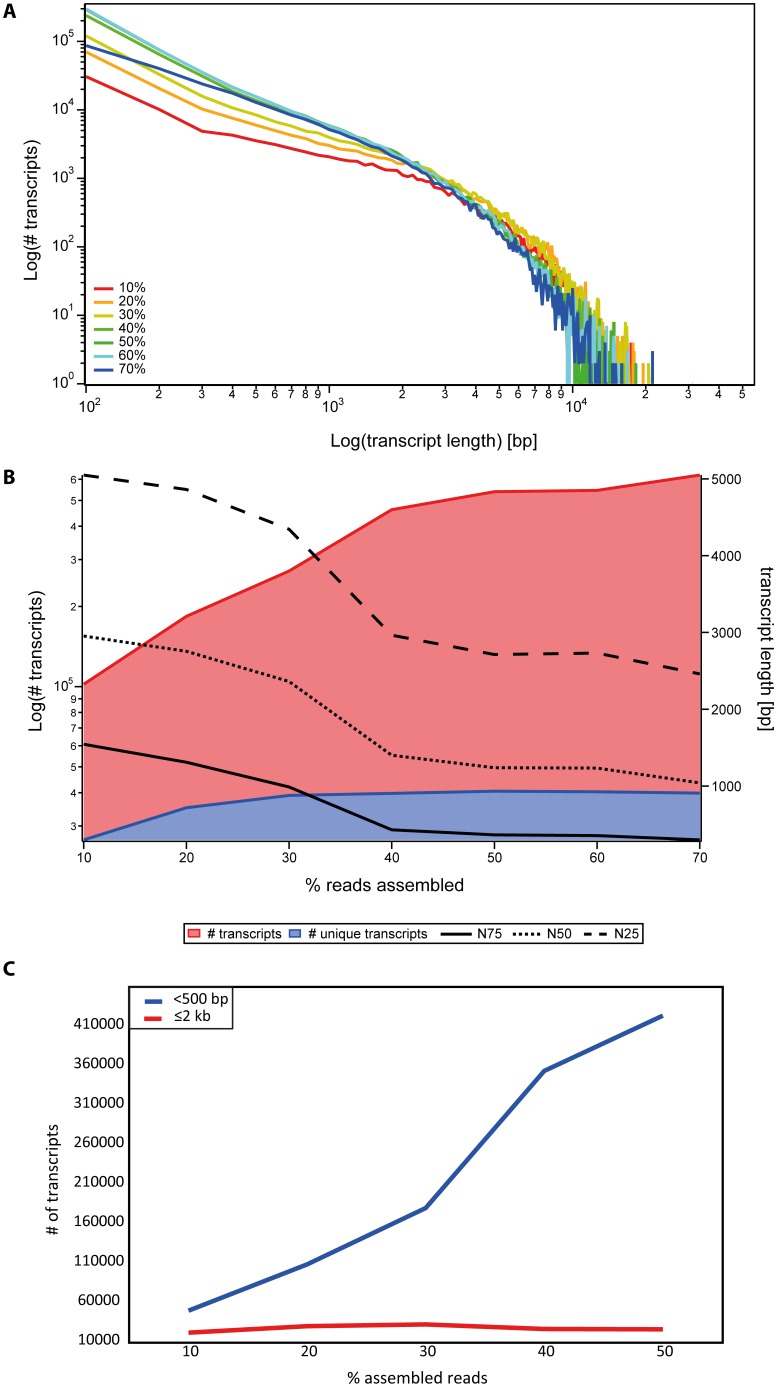
Estimation of transcripome completeness.Progressively larger subsets of reads (10%–70%) originating from one Illumina lane (embryonic sample, Sample A) were assembled de novo. A The use of more reads resulted in the assembly of very long transcripts, but more short transcripts were observed. B Using more Illumina reads allowed the assembly of more transcripts. The number of unique transcripts does not increase if more than 40% of the reads of one Illumina lane are used. Similarly, the NXX values of the subassemblies where more than 30%–40% of the reads were assembled are lower due to the high number of short transcripts. C The number of transcripts shorter than 500 bp increases much more than the number of transcripts longer than 2 kb if more reads are assembled.